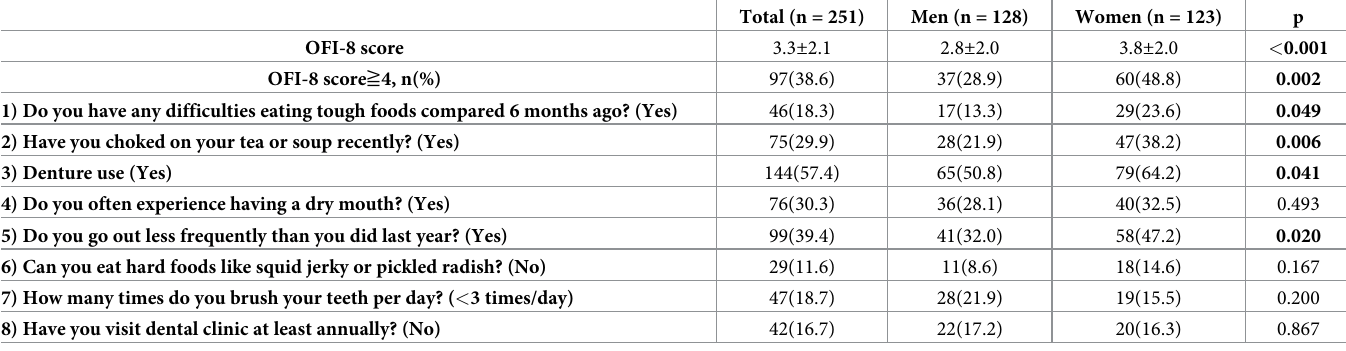
Table 2. Results of the OFI-8